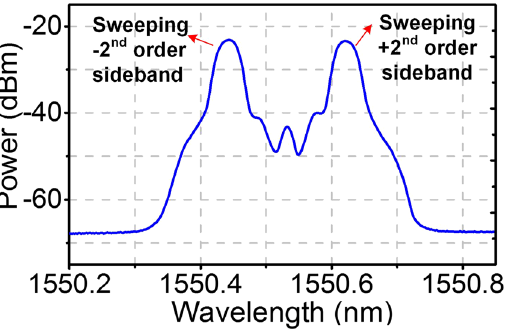
Figure 2. Measured optical spectrum after the DPMZM. Two frequency sweeping sidebands are generated.